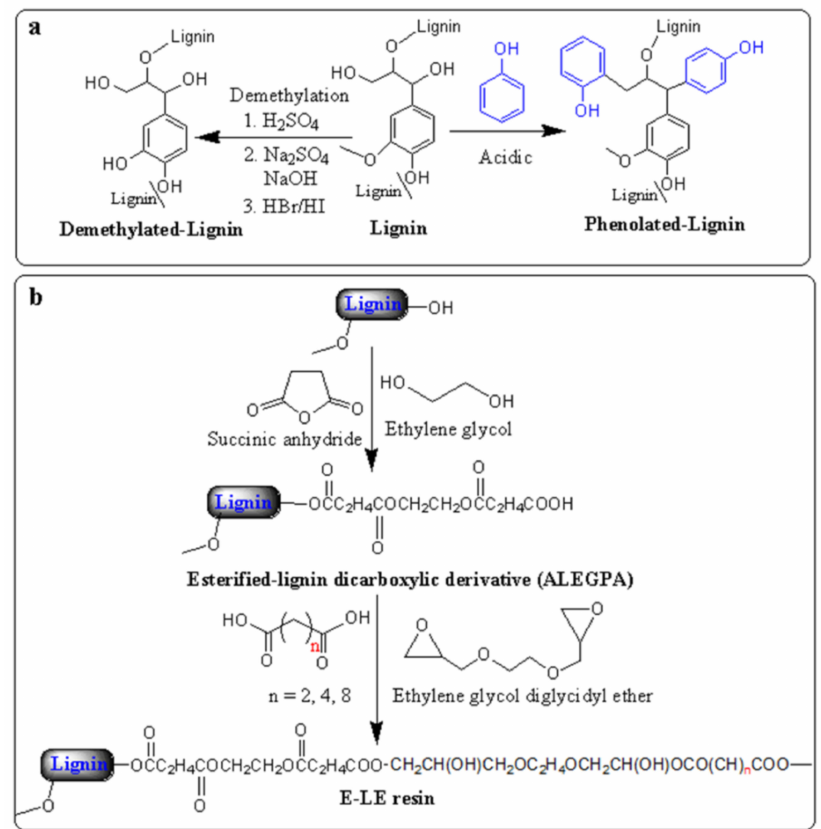
Figure 2. Synthetic diagram route of ( a ) demethylation and phenolization of the lignin and ( b ) ester-based lignin epoxy (E-LE)